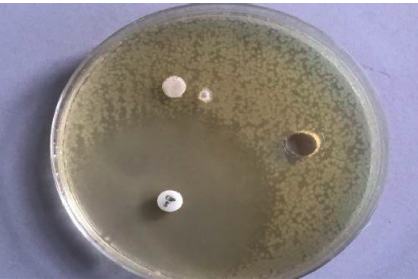
Figure 5: Antibacterial activity of Camellia sinensis AgNP against Escherichia coli.